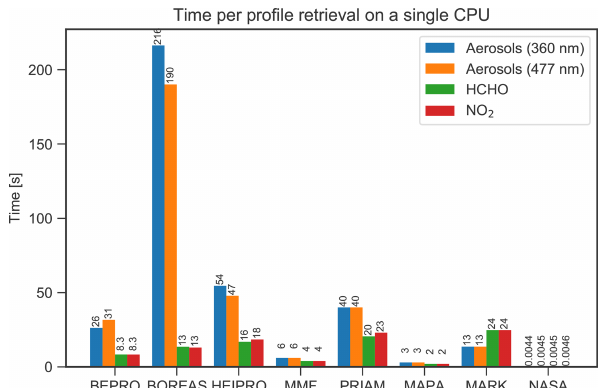
Figure 22. Time in seconds for the retrieval of a single profile on a single CPU core for each participant, separated by the target species as denoted in the legend.